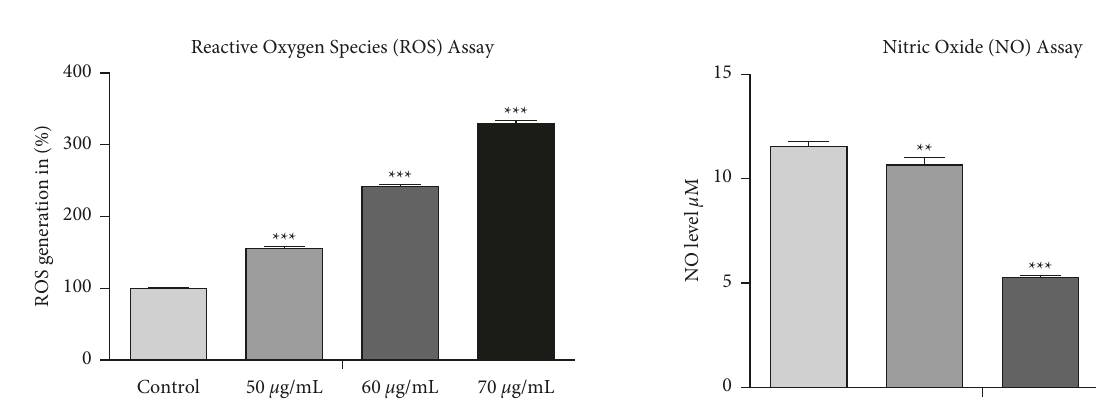
Figure 11: Percentage of ROS release in A549 cell line after treated with SP-ZnONPs. Figure 12: Concentration of NO in A549 cell line after treatment of various concentrations of